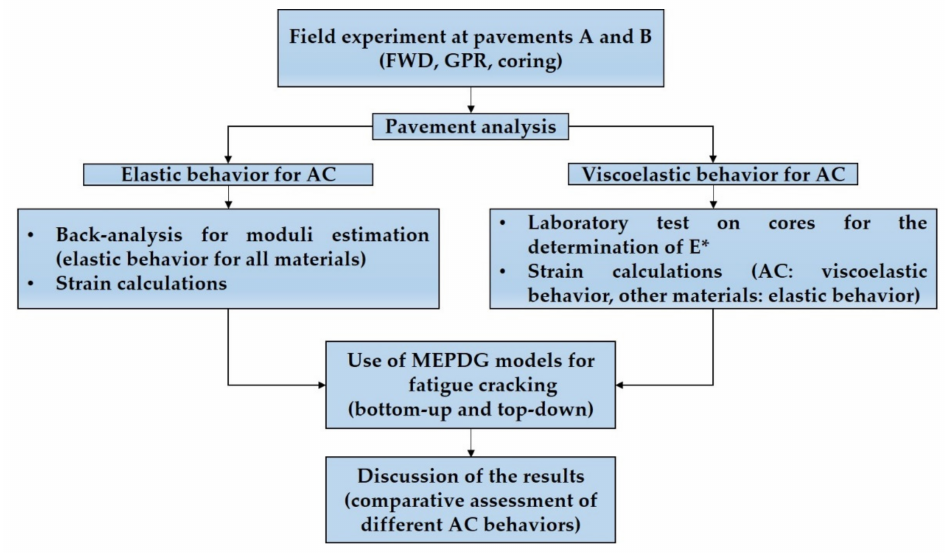
Figure 4. Research